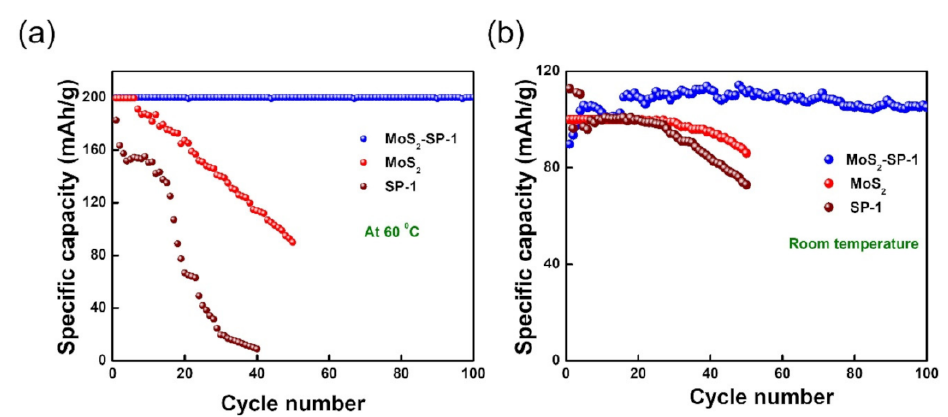
Figure 4. ( a , b ) Cycling performance of 1T-MoS 2 /SP-1, 1T-MoS 2 , and SP-1 at 60 ◦ C and room temperature,